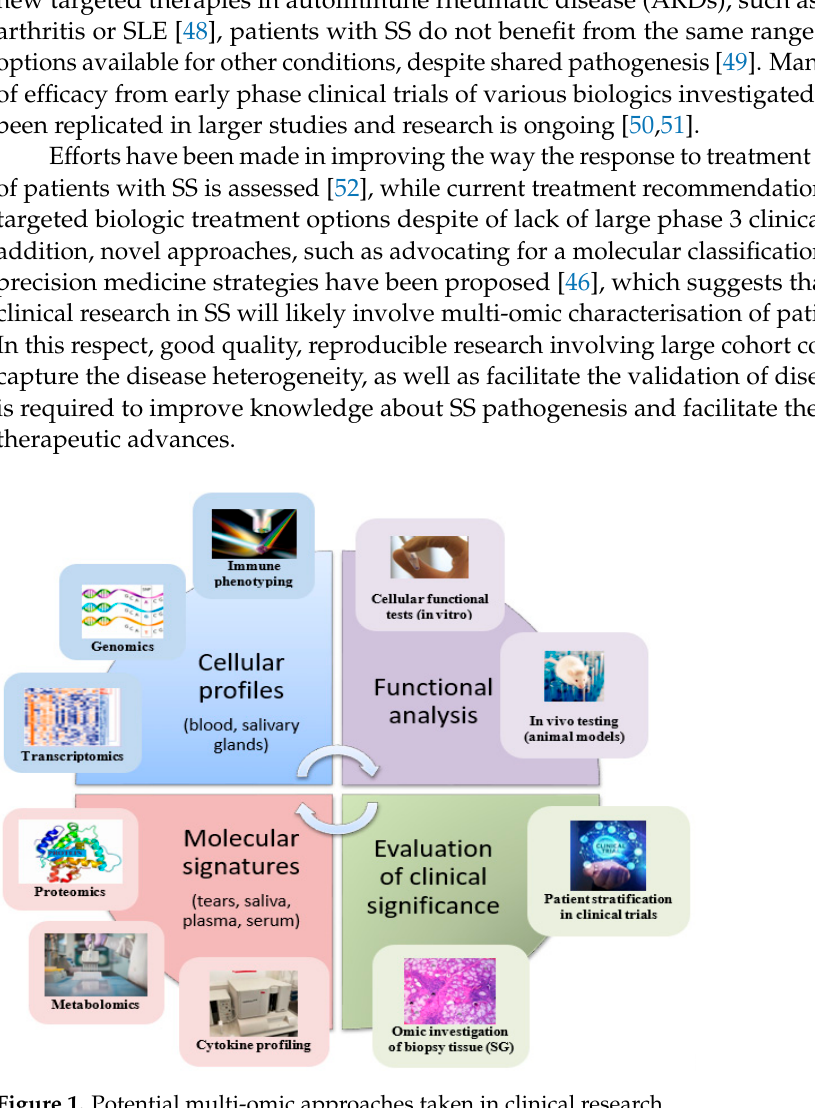
Figure 1. Potential multi-omic approaches taken in clinical research.